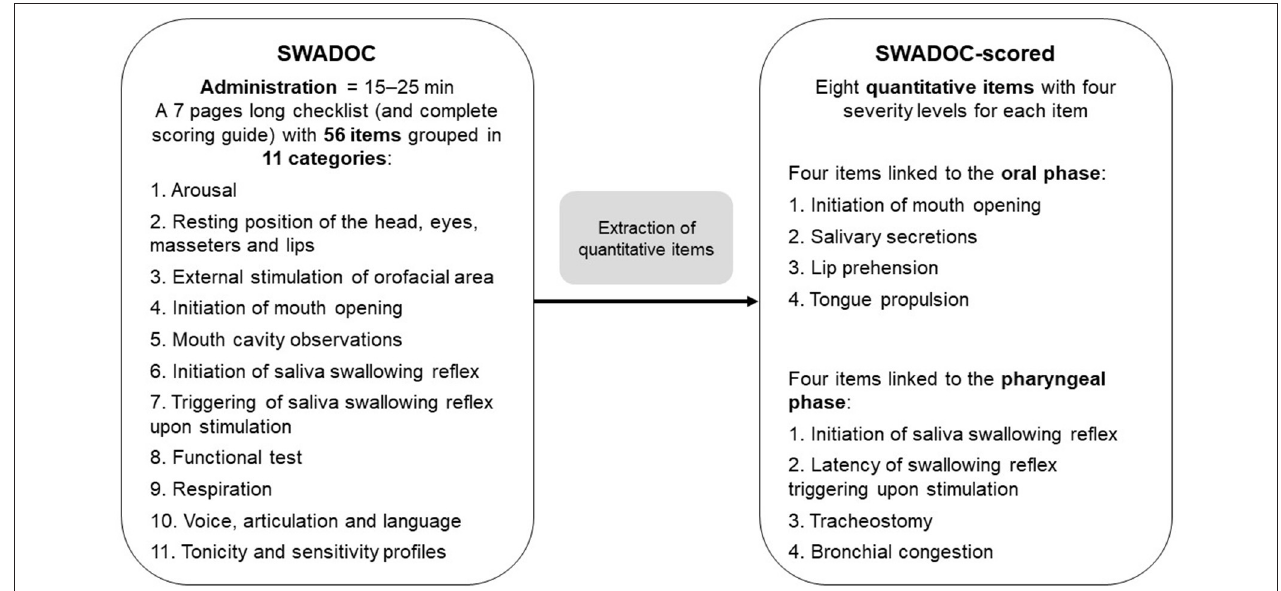
FIGURE 1 | Description of the SWADOC. ENT, Ear, Nose, and Throat; SWADOC, SWallowing Assessment in Disorders Of Consciousness.